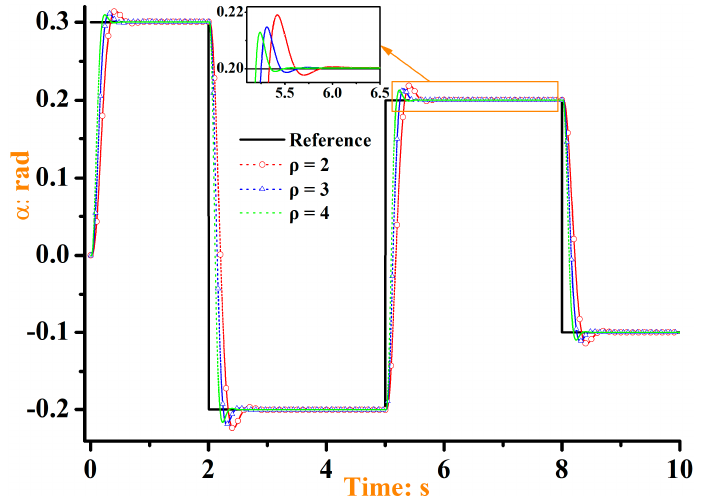
Figure 8. Validation with different control order ρ : Attack angle α .